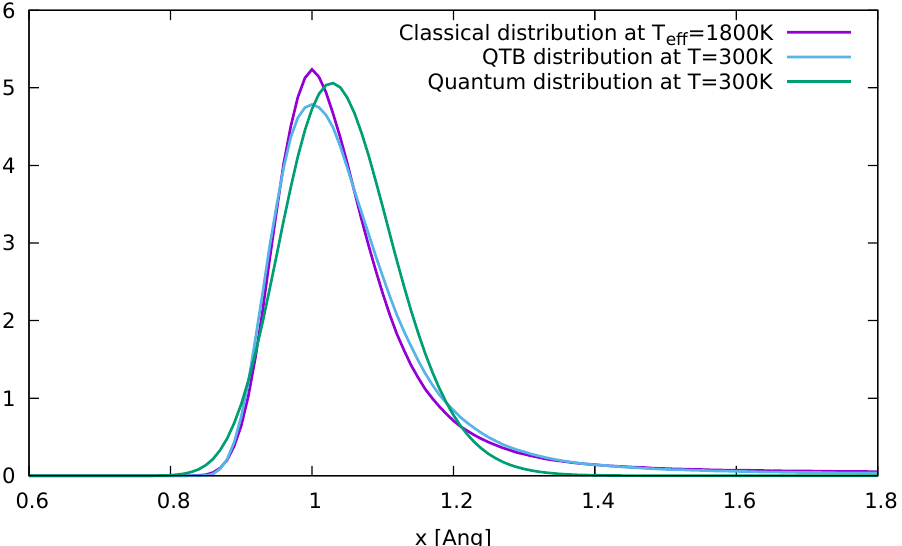
Figure 6. Comparison of the particle position distributions for a classical Langevin simulation at the QTB effective temperature T eff = 1800 K with the corresponding QTB distribution at T = 300 K and the exact quantum distribution at the same